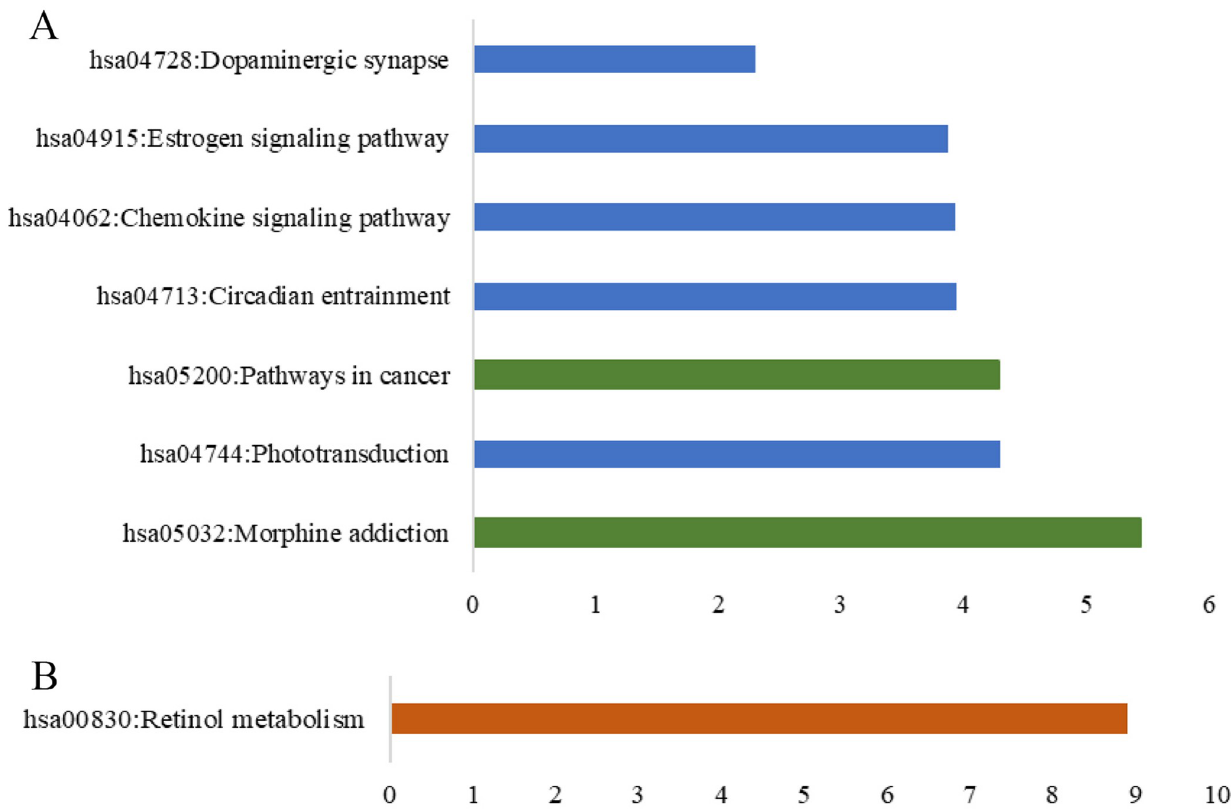
Fig 4. Enriched KEGG pathways. A. Signaling pathways involved in GRK4 and its interacting proteins. Blue represents Organismal Systems, and green represents Human Diseases; B. Signal pathways involved in RDH8 and its interacting proteins. Red represents Metabolism.